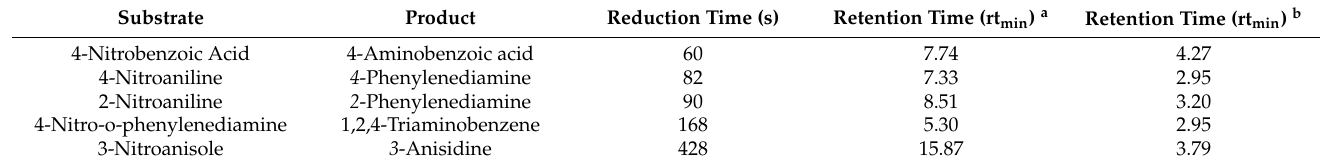
Table 2. The reduction and retention times of nitro compounds.